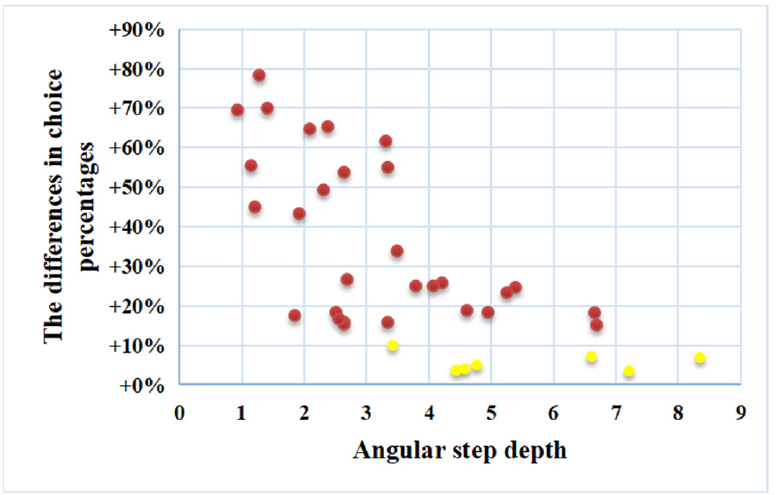
Figure 10. Differences in the choice percentages of the recommended routes with different angular step depths.